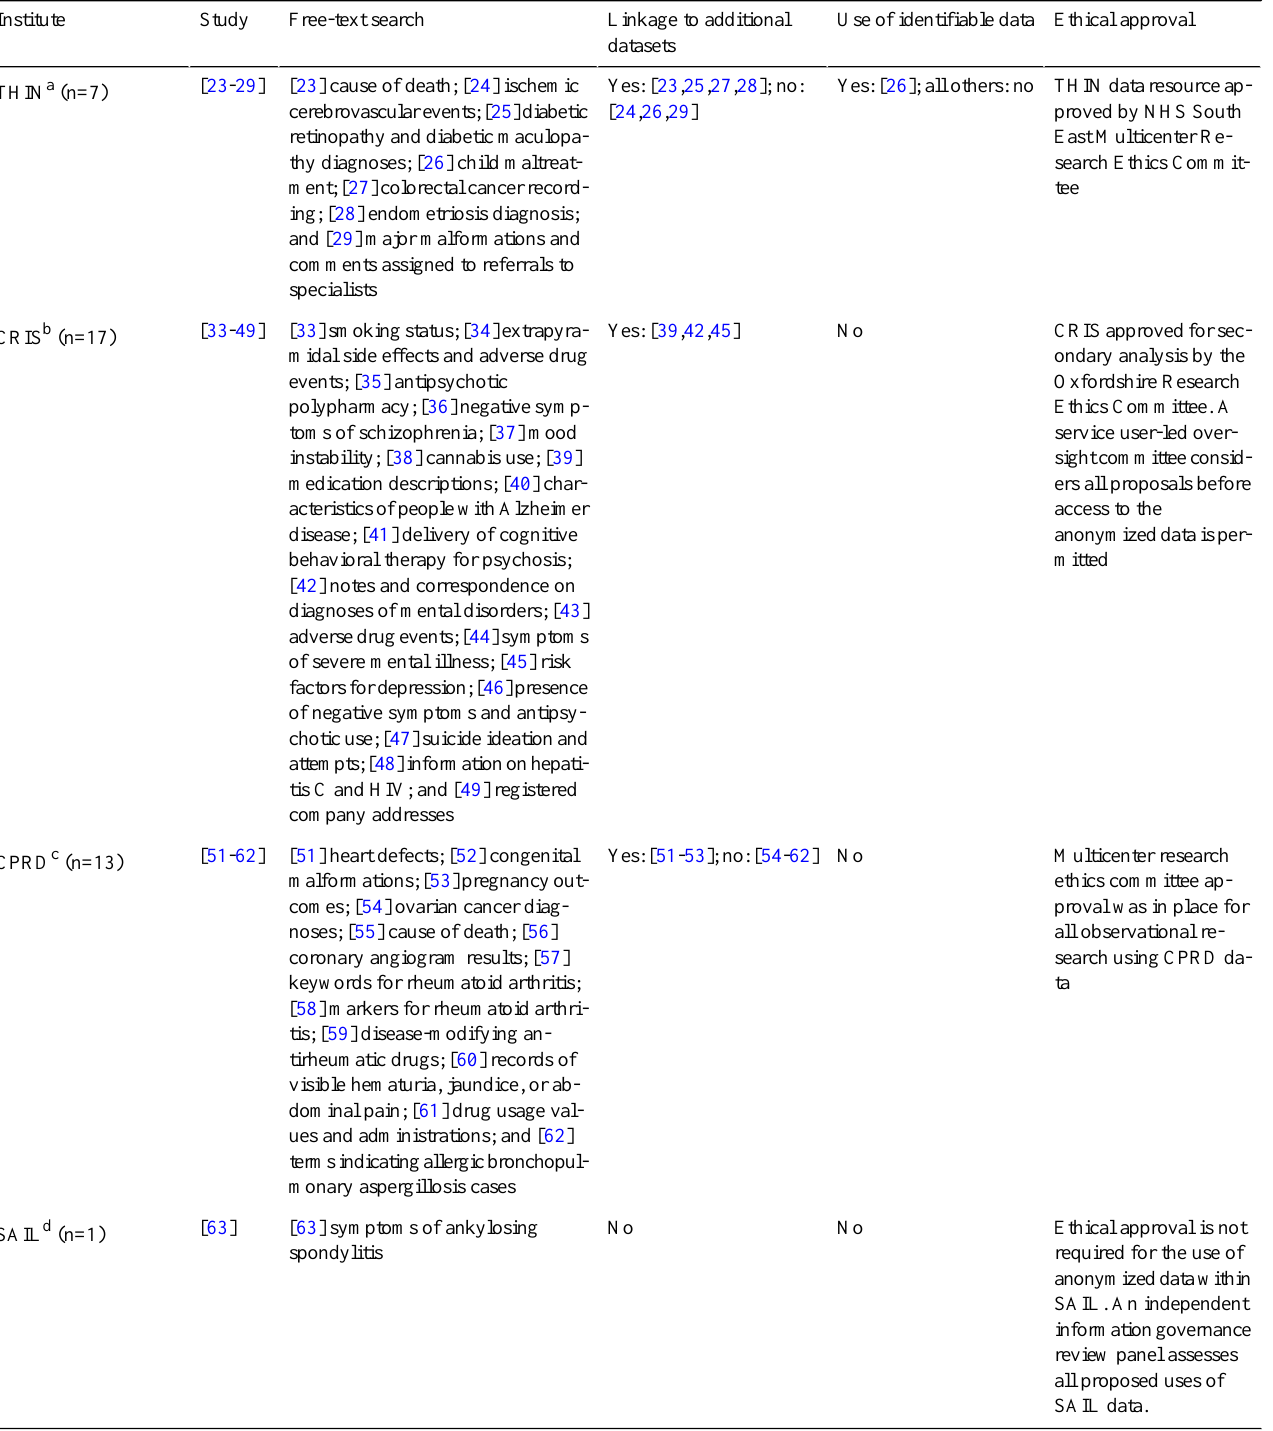
Table 2. Key information from the literature